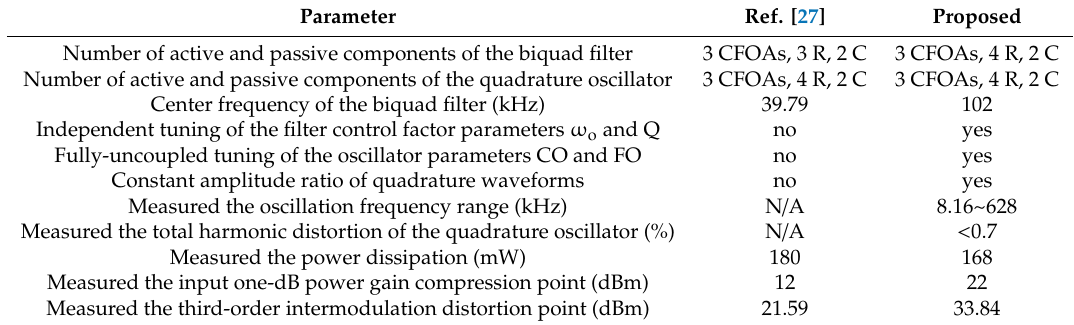
Table 2. Characteristic comparisons with recent previous